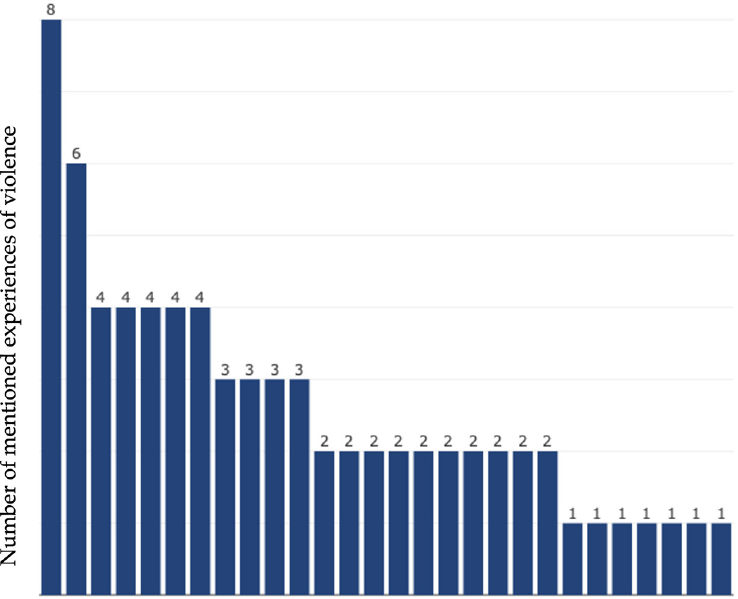
Figure 1. Participant’s mention of experiences of violence (each bar representing one participant) . Rape and sexual assault were especially common in the participants’ narratives.